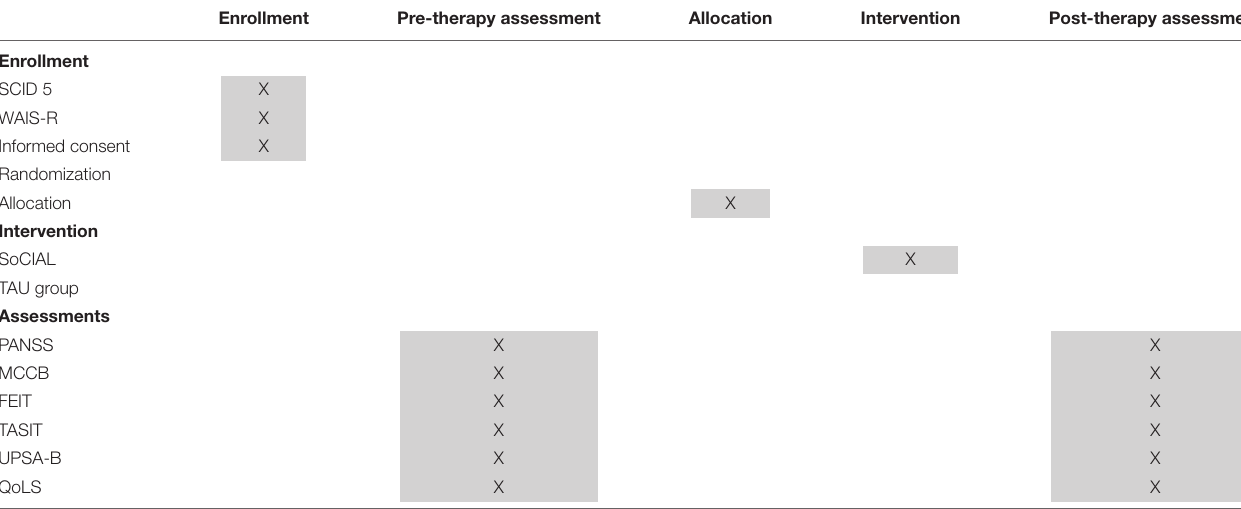
TABLE 1 | Time schedule of the